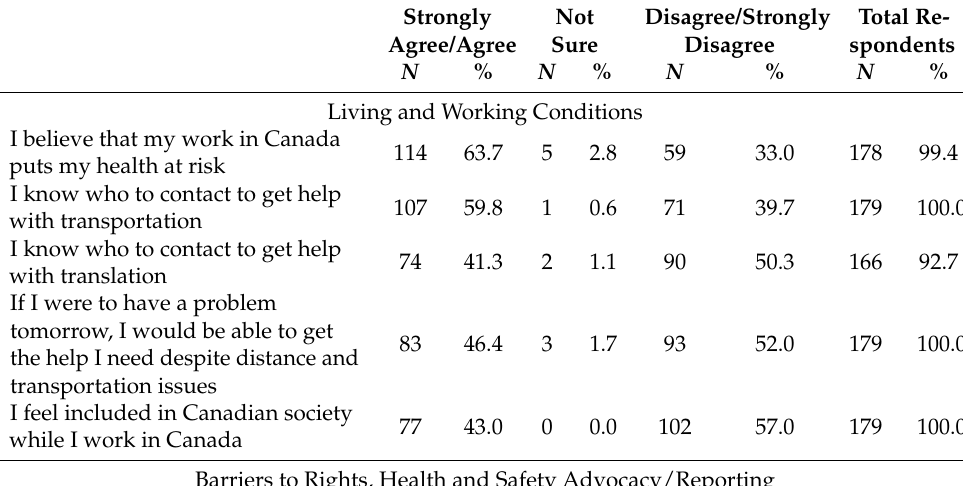
Table A2. Trichotomized survey results of Likert-scale questions concerning knowledge, attitudes and